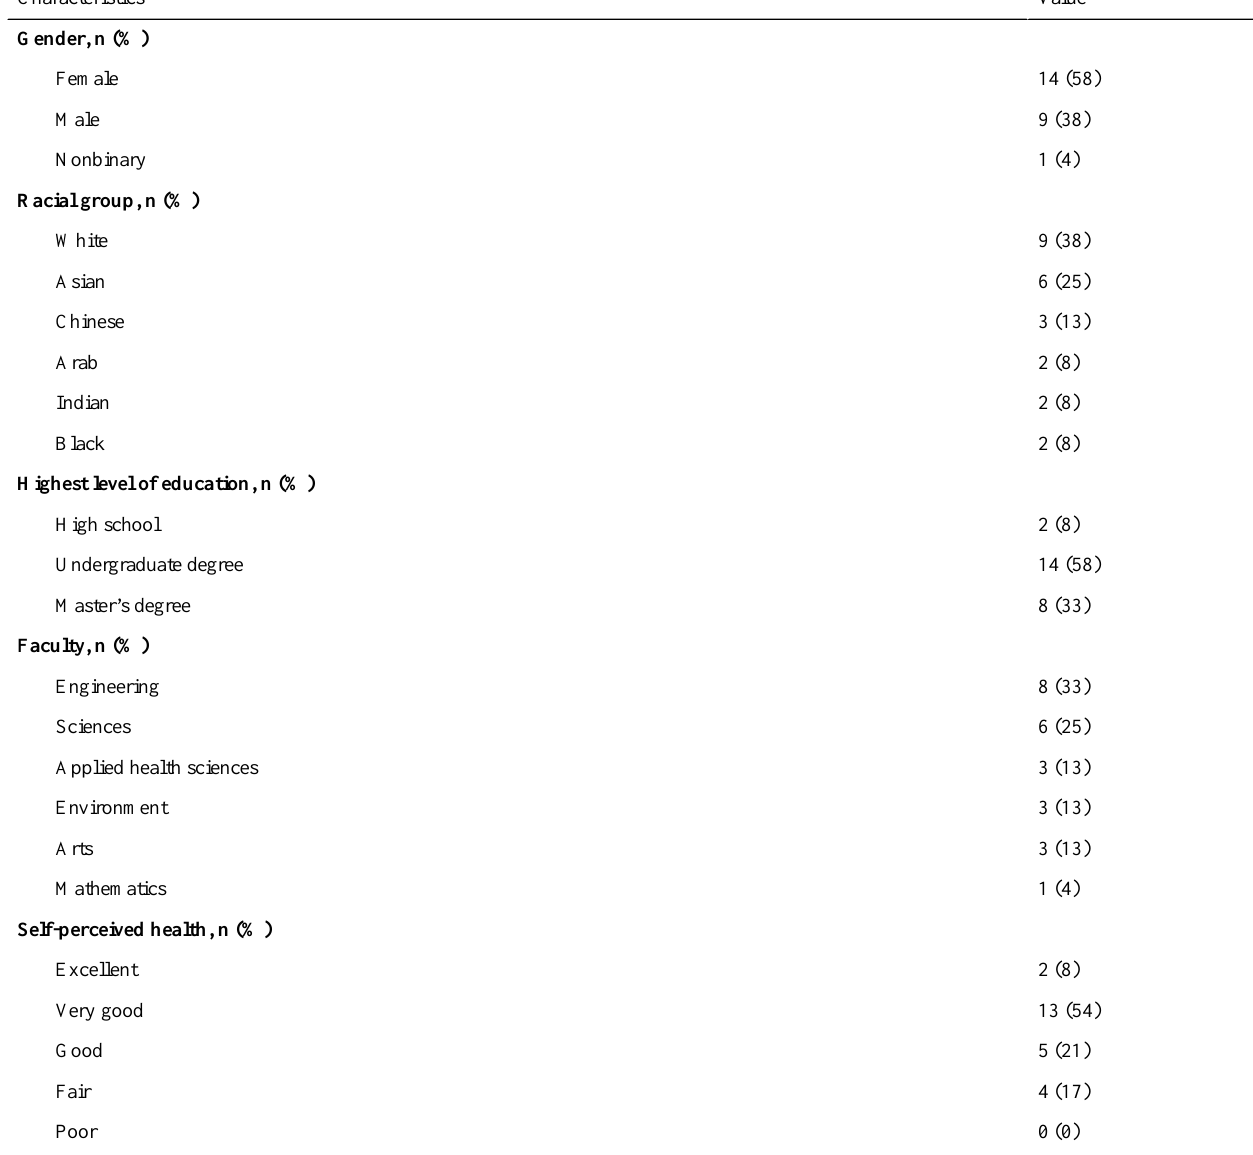
Table 1. Participant information (N=24).